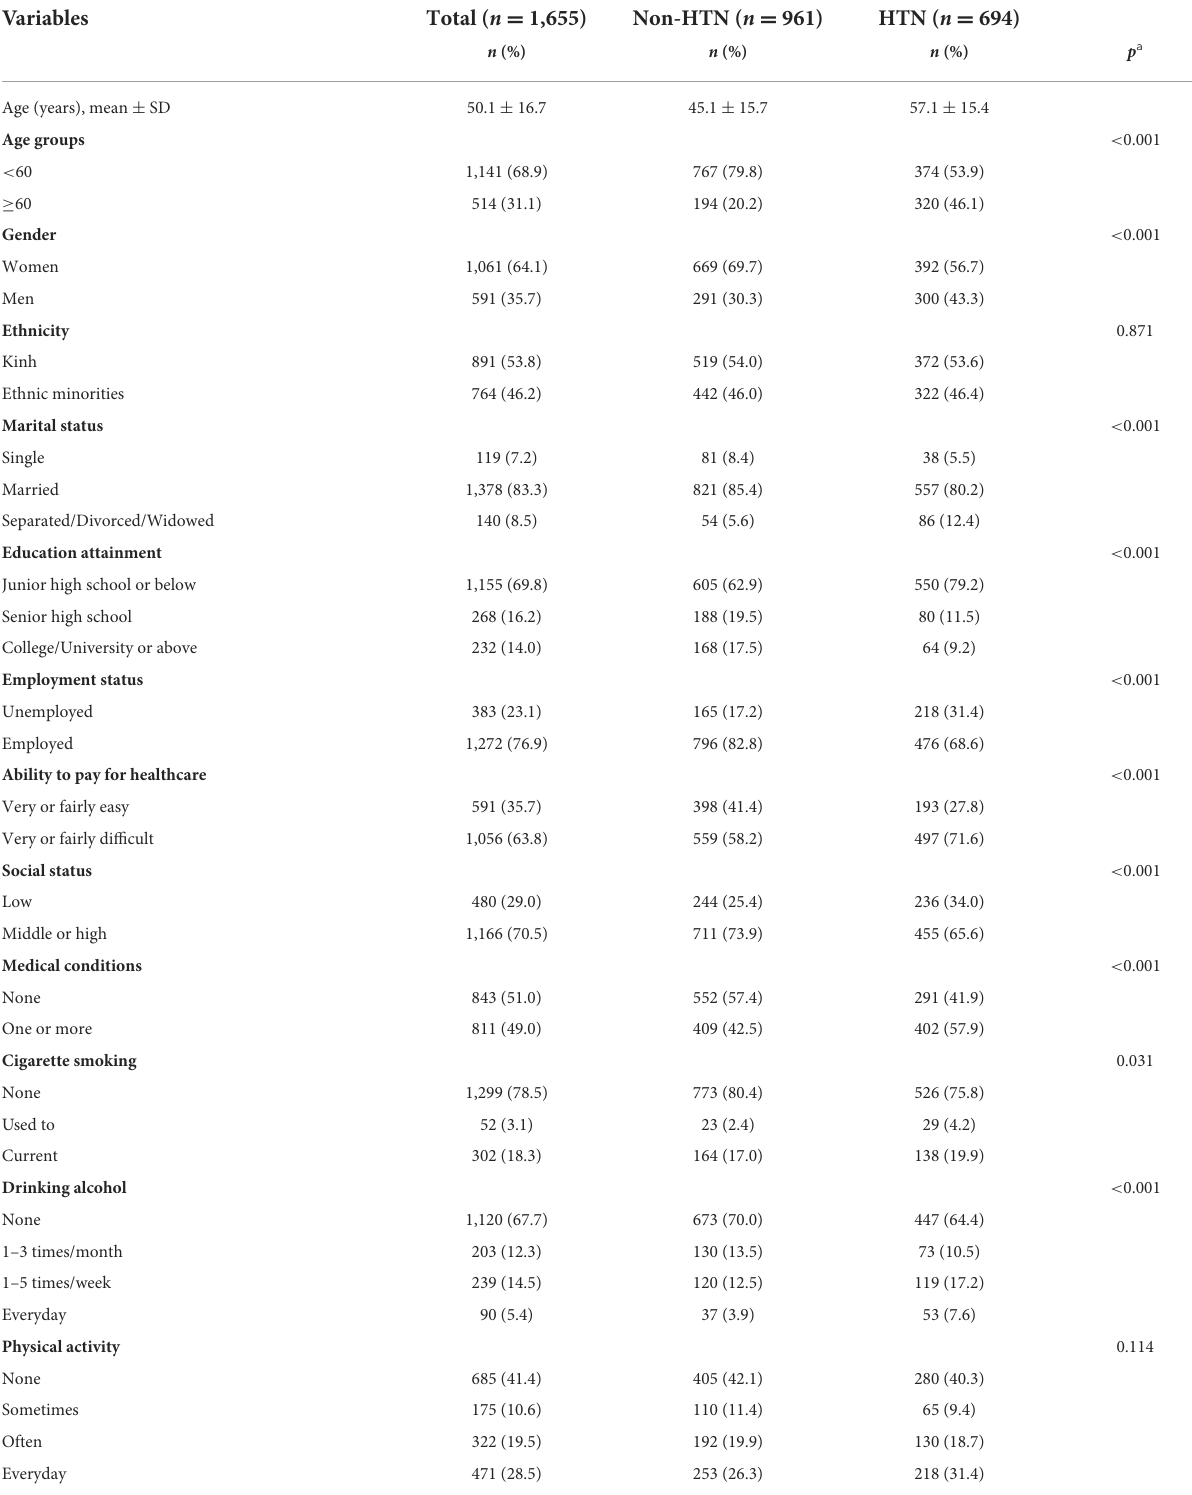
TABLE 1 Characteristics of participants ( n =